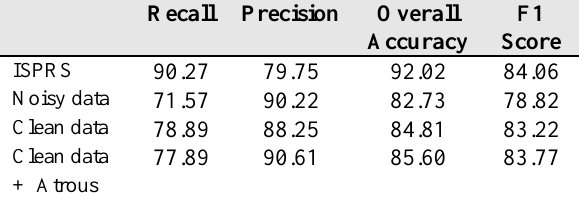
Table 1. Performance of the FCN